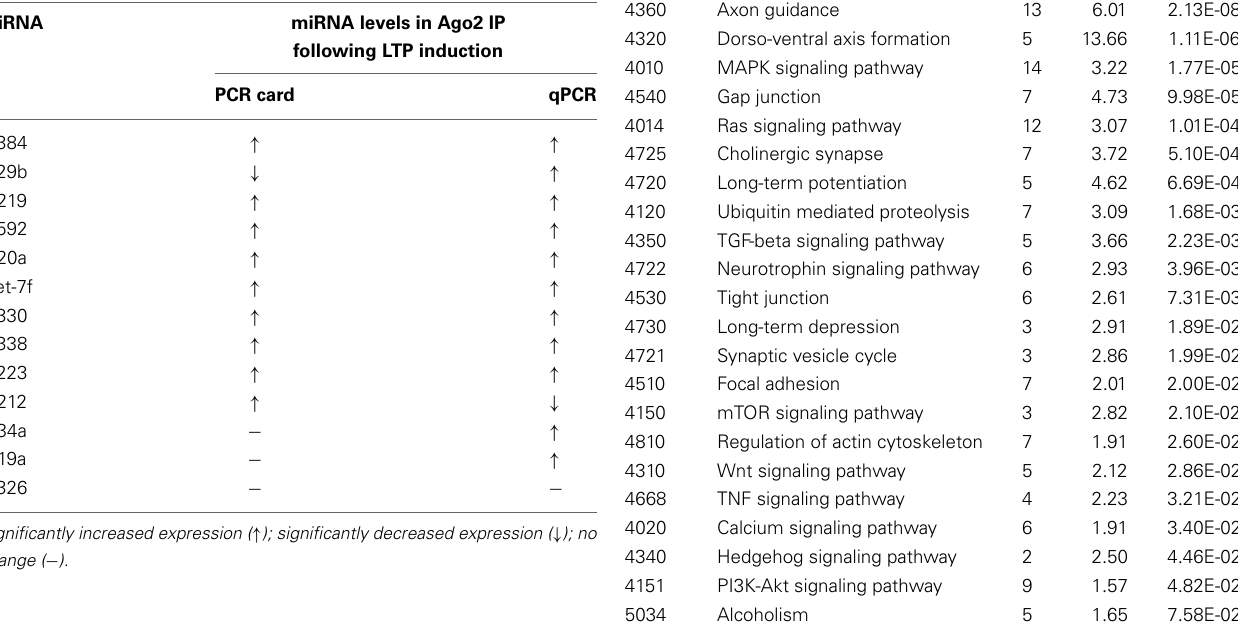
Table A1 | Comparison of PCR card screening to Taqman qPCR validation results.